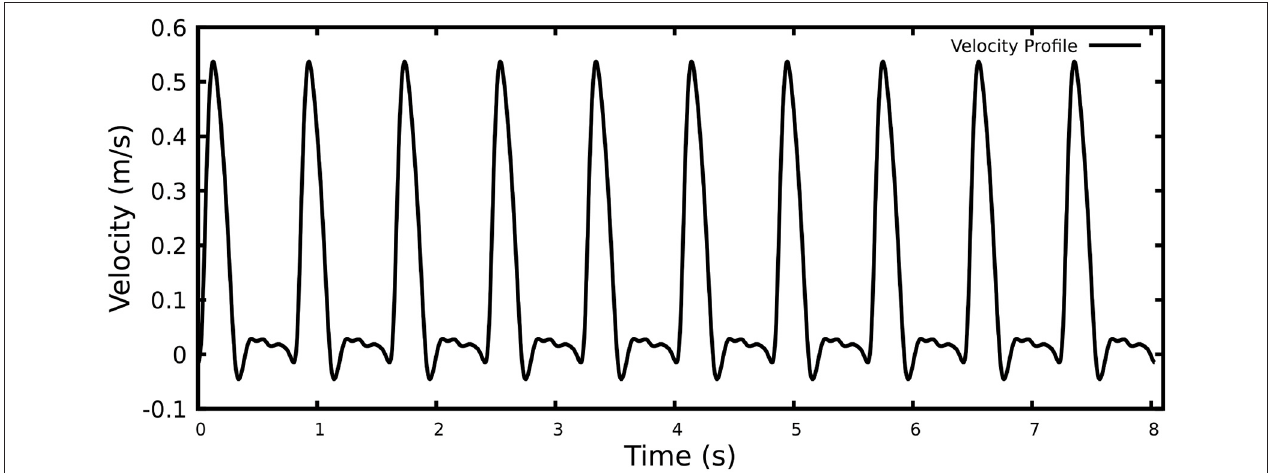
FIGURE 2 | Realistic pulsatile velocity profile for 10 heartbeats.